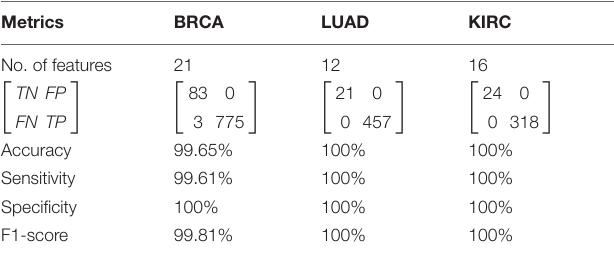
TABLE 3 | The diagnosis results of three cancer by HFS-SLPEE (%).